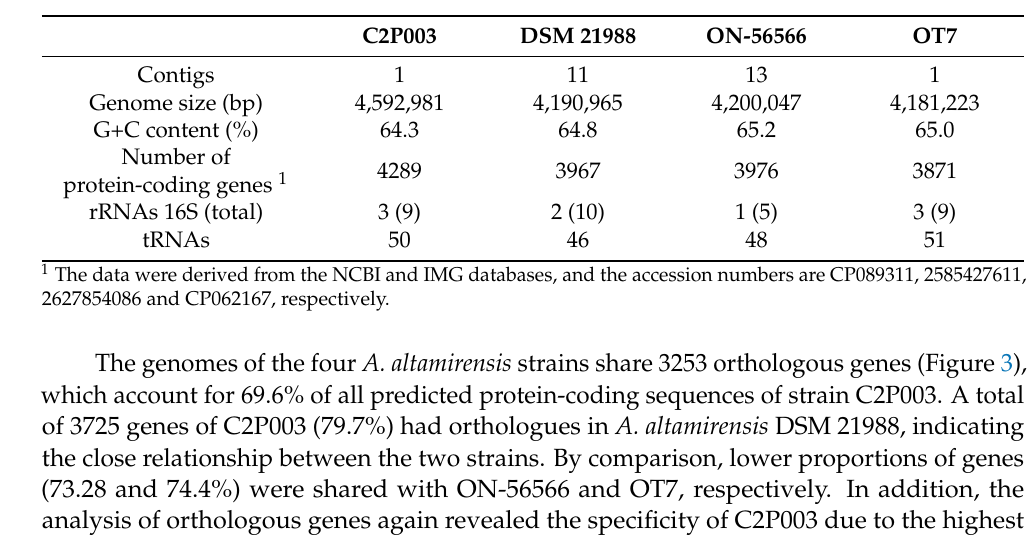
Table 1. Genome annotation statistics of the Aureimonas altamirensis strains C2P003, DSM 21988, ON-56566 and OT7.